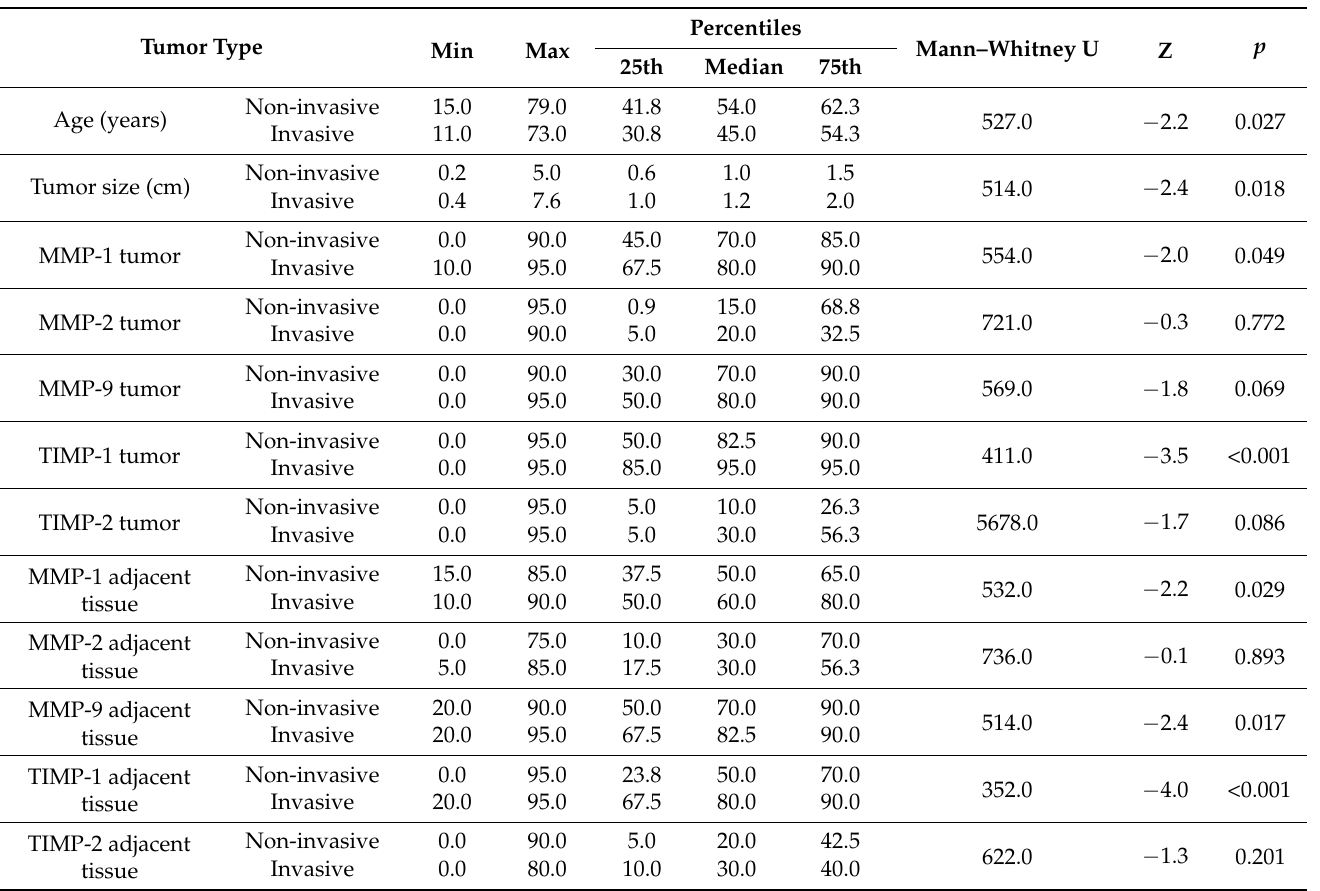
Table 2. Differences in age, tumor size, MMP-1, MMP-2, MMP-9, TIMP-1, and TIMP-2 expression in tumor cells and corresponding adjacent tissue between non-invasive tumors (N = 30) and invasive tumors (N = 50): Mann–Whitney U tests.